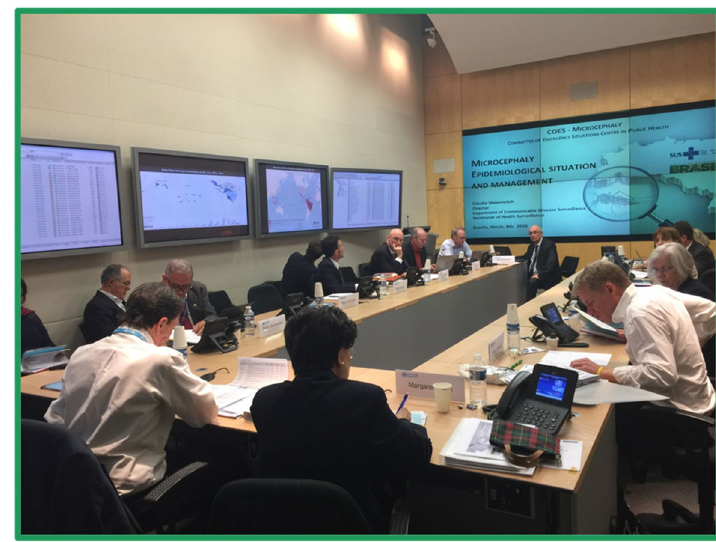
Fig. 5 The IHR Emergency Committee at work assessing a Public Health Emergency of International Concern